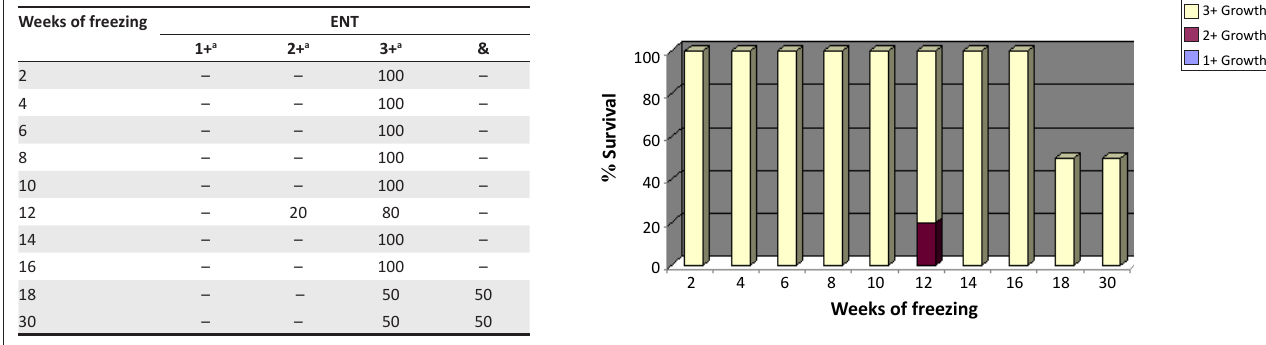
ENT, Enterococci ( Escherichia coli ). &, indicated no growth. a FIGURE 6: Percentage survival and viability of Escherichia coli for frozen